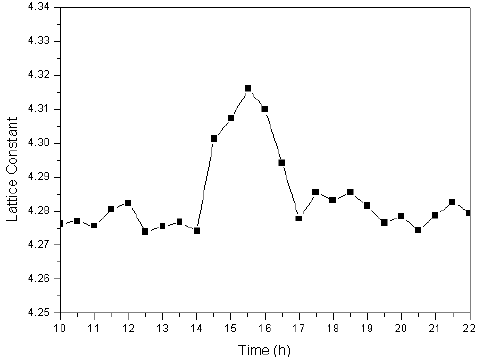
Figure 5. Lattice constant of the Cu 2 O solid solution as a function of time.